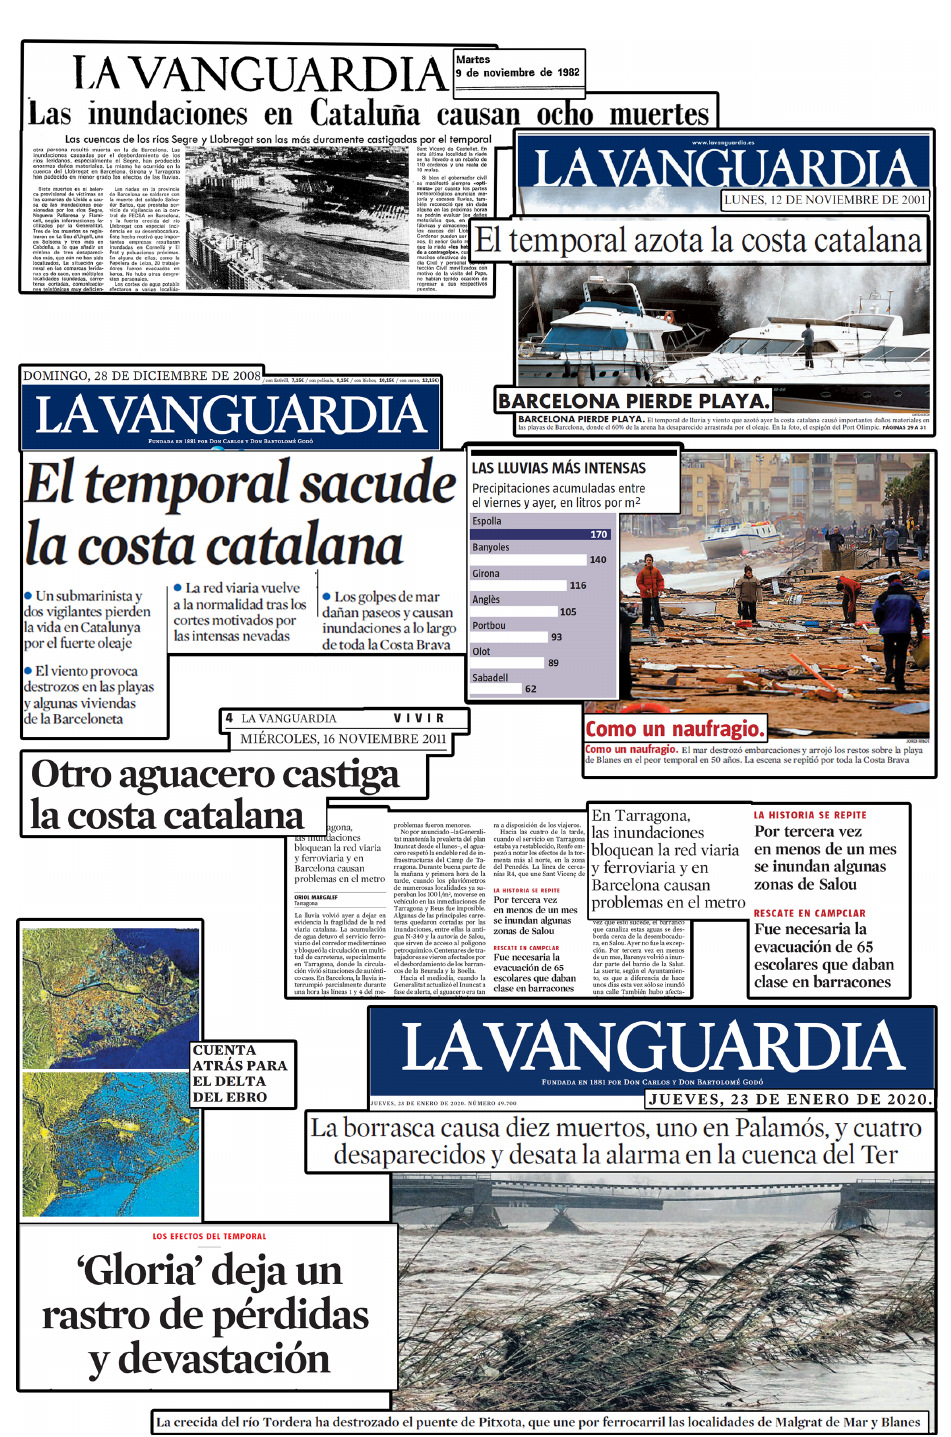
Figure 13. Headlines in a local newspaper (La Vanguardia) after the impact of selected events (Figs. 11 and 12). From top left to bottom right: (9 November 1982) “Eight dead caused by floods in Catalonia”; “Segre and Llobregat basins, the most affected by the event”. (12 November 2001) “The storm hits the Catalan coast”; “Barcelona loses its beaches”. (28 December 2008) “The storm shakes the Catalan coast”; “The most intense rains”; “Like a wreck”. (16 November 2011) “The downpour punishes the Catalan coast”; “Flooding disrupts train and under- ground networks in Tarragona and Barcelona”; “Floods in Salou for the third time in a month”; “65 children evacuated from poorly built schools”. (23 January 2020) “Gloria leaves a pathway of destruction and losses”; “The storm causes 10 dead (one in Palamós), four missing and all alarms triggered at the Ter basin”; “Final countdown at the Ebro